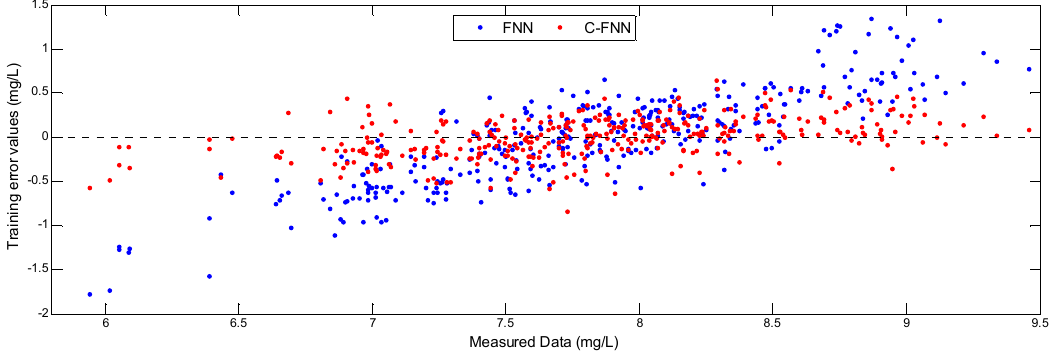
Figure 11. The testing output of the FNN, C ‐ FNN for BOD.